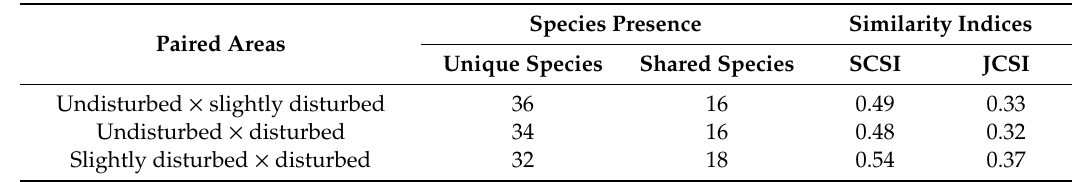
Table 3. Using Sorensen’s Coe ffi cient Similarity Index (SCSI) and (JCSI) Jaccard Coe ffi cient Similarity Index to compare species composition among three contrasting forest